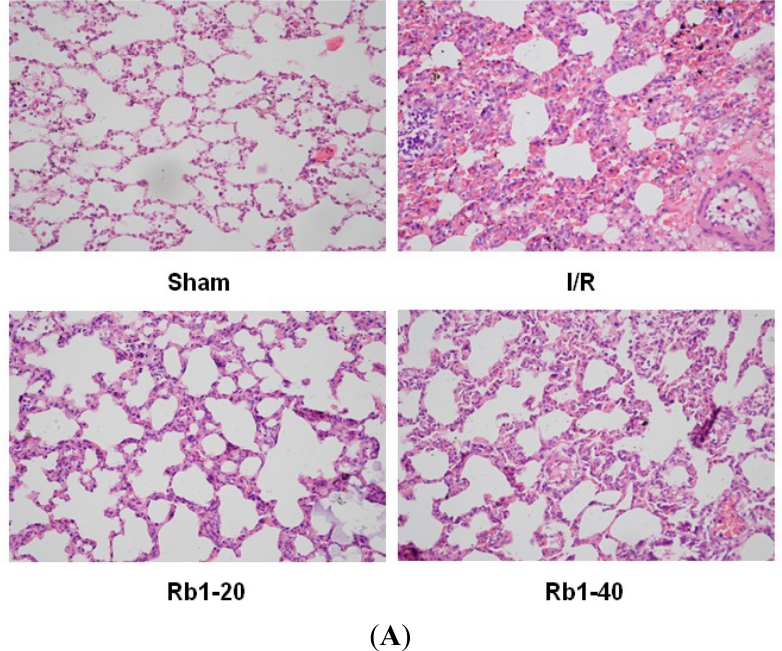
Figure 3. ( A ) Effects of Rb1 on lung injury after intestinal I/R. (HE ×400); ( B ) Lung pathological scores of different